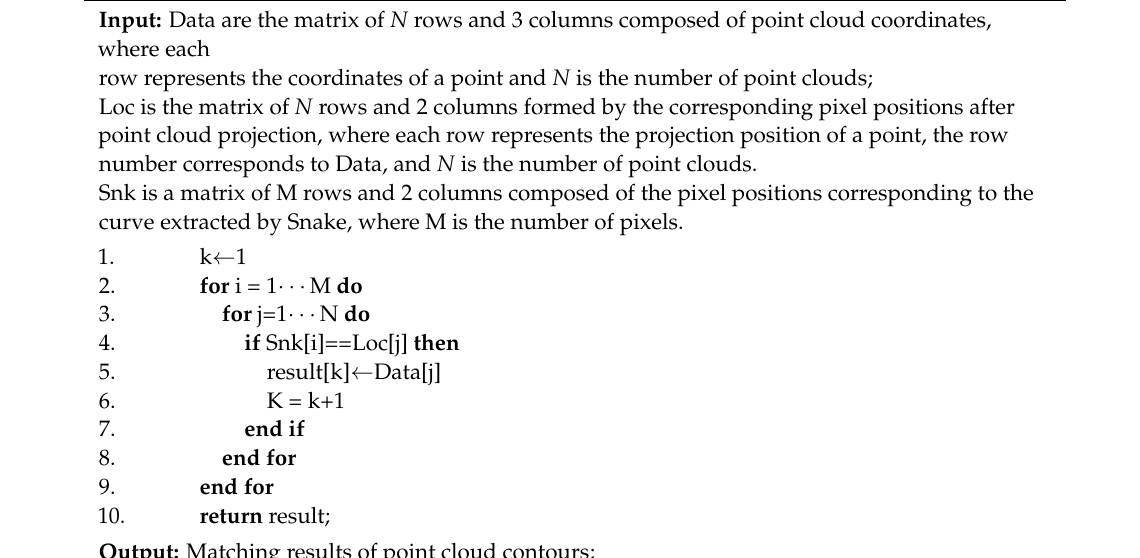
Algorithm 1: Point Cloud Back-Projection Using Pixel